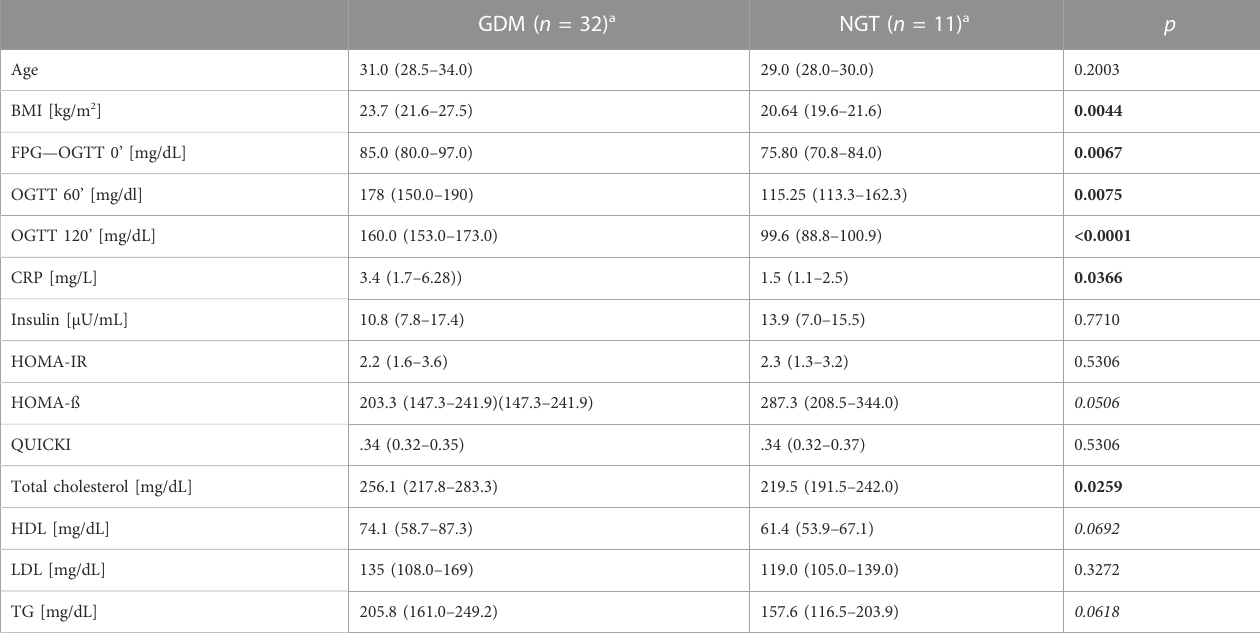
TABLE 1 Biochemical and clinical parameters of the GDM and NGT